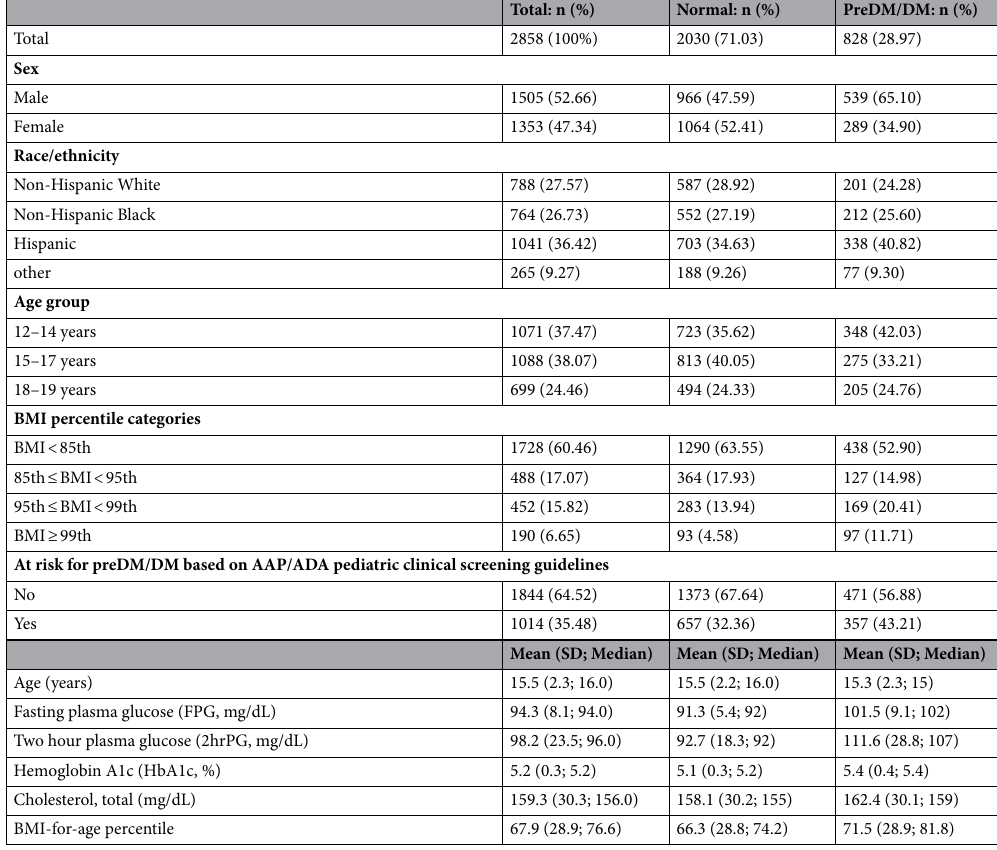
Table 2. Characteristics of the study population (n = 2858). ADA American Diabetes Association; AAP American Academy of Pediatrics; preDM prediabetes; DM diabetes; BMI body mass index. SD standard deviation. Results based on unweighted data.